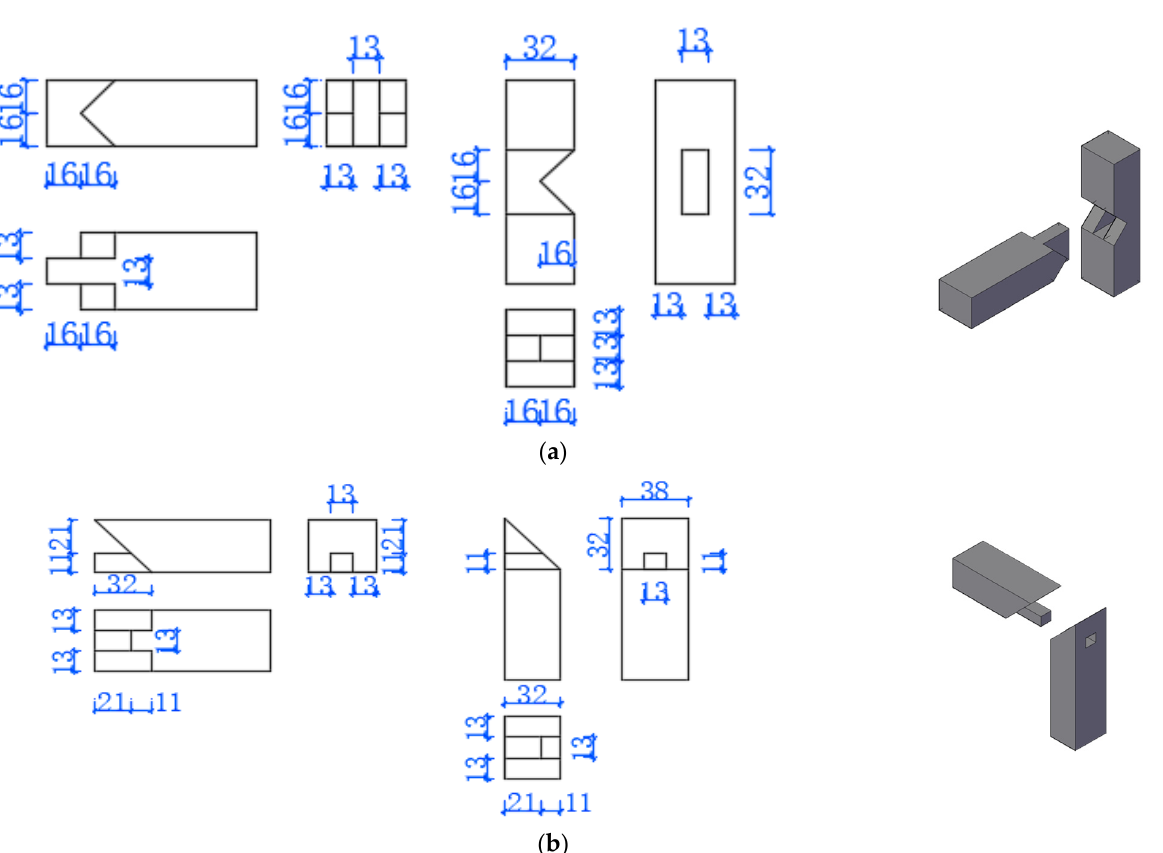
Figure 4. Dimensions of the mortise and tenon joints (unit: mm): ( a ) mortise of the Bianting and tenon of the Zhongmo; ( b ) mortise of the Bianting and tenon of the Shangmo/Xiamo.